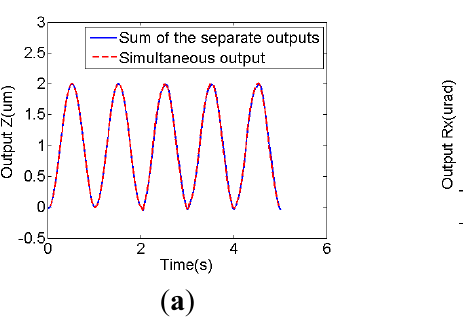
Figure 2. Linearity of the 3-DOF piezo-actuator-driven stage: ( a–c ) comparison